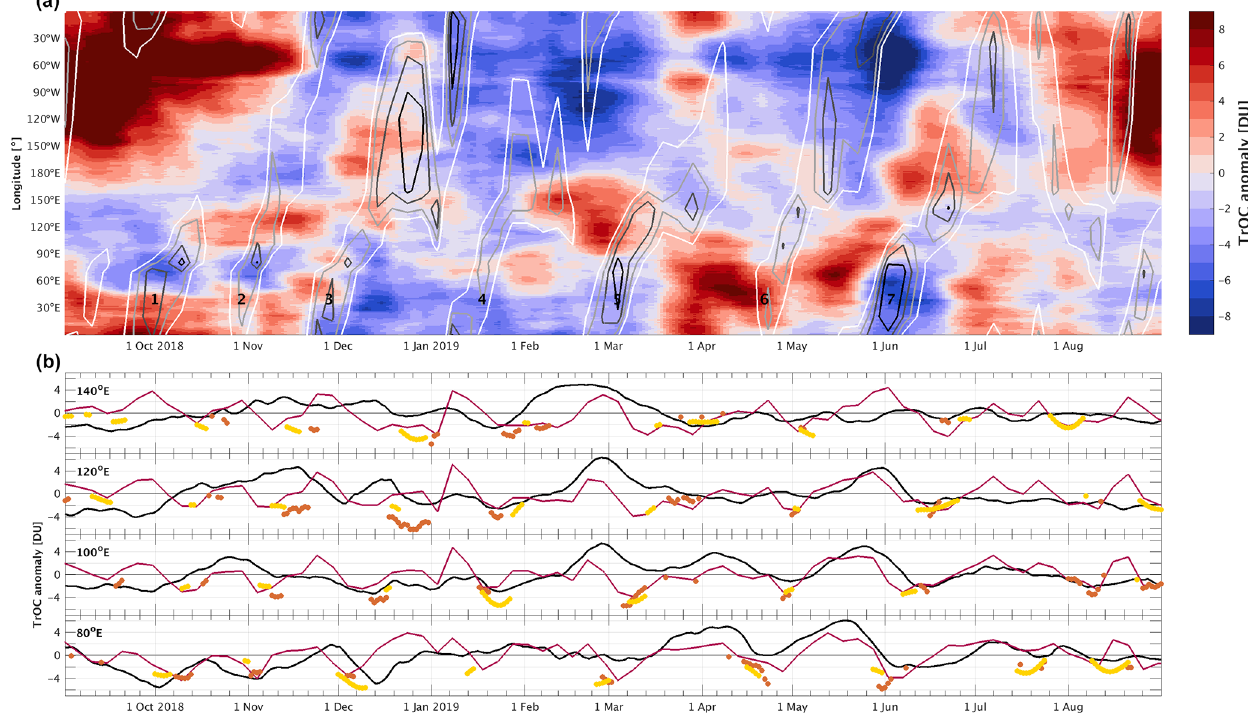
Figure 14. (a) Hovmöller diagram of 15d moving mean TROPOMI tropospheric ozone column anomaly between September 2018 and August 2019 over the inner tropics (5 ◦ S–5 ◦ N). Contours show the NOAA/CPC Madden–Julian Oscillation index, ranging from − 2 (black) to − 0.5 (white) in steps of 0.5. (b) Time series of TrOC anomaly (black) and CPC index (purple) at four longitudes in the equatorial Indian and western Pacific oceans. Markers represent amplitude derived from the RMM (red) and OMI (orange) indices, in the phase quadrant corresponding to the shown longitude. All MJO indices are scaled by a factor of 2, and their sign is such that strong convective activity corresponds to more negative displayed